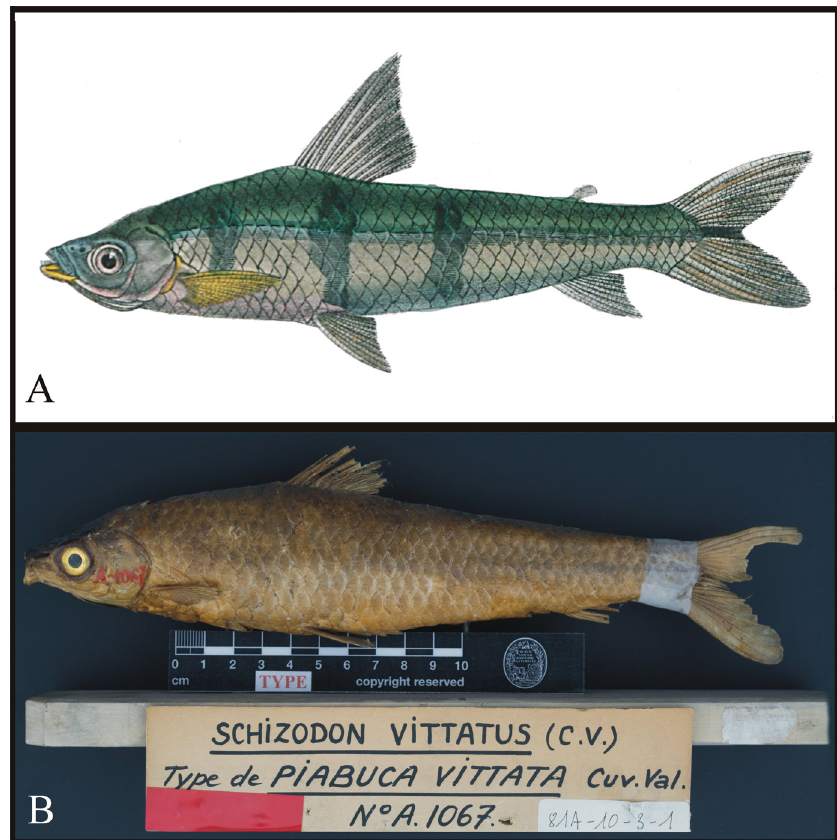
FIGURE 1 | Schizodon vittatus. A. drawing published by Castelnau (1855) illustrating the holotype; B. holotype of Piabuca vittata , MNHN-IC-A-1067, 285.0 mm SL, Brazil, Araguaia River (source: http://coldb.